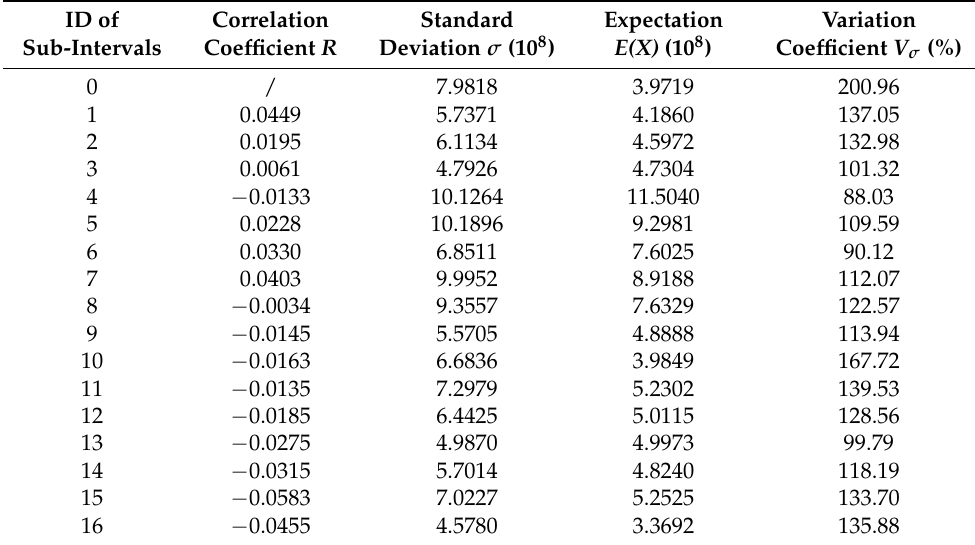
Table 2. The randomness tests of WRID algorithm. ID of